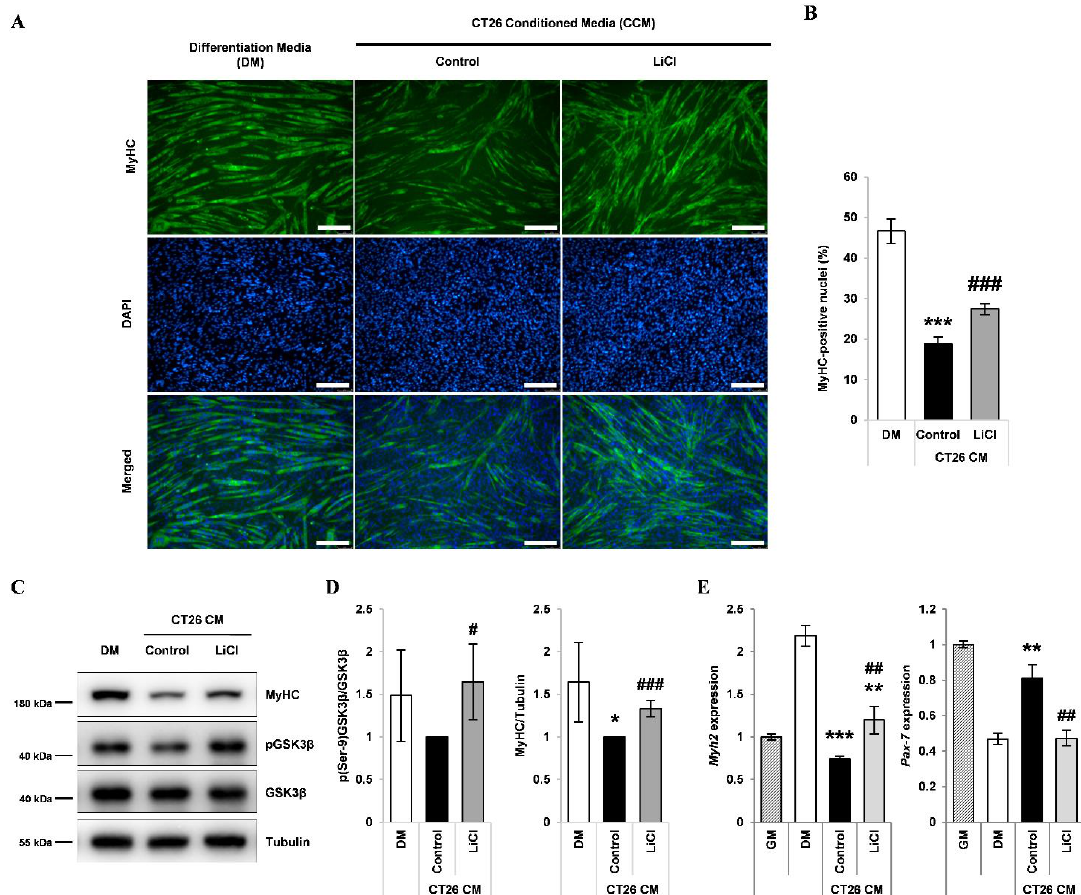
Figure 2. LiCl ameliorates the inhibition of myoblast differentiation by CT26 colon carcinoma cell-conditioned media (CCM). ( A ) Immunofluorescence staining after 72 h of culture in the following media: (1) differentiation media (DM), (2) CCM only, and (3) CCM and 5 mM LiCl (n = 4). ( B ) Quantified ratio of MyHC-positive nuclei in immunostaining